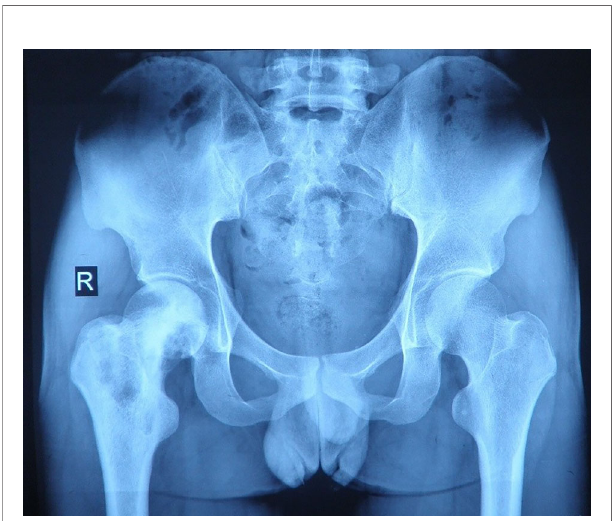
FIGURE 1 | Plain radiography of pelvis at the fi rst week of local pain showed fl ake bone destruction in right femoral